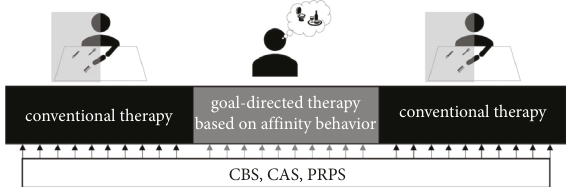
Figure 2: Experimental study procedure. CBS: catherine bergego scale, CAS: clinical assessment for spontaneity, and PRPS: pitts- burgh rehabilitation participation